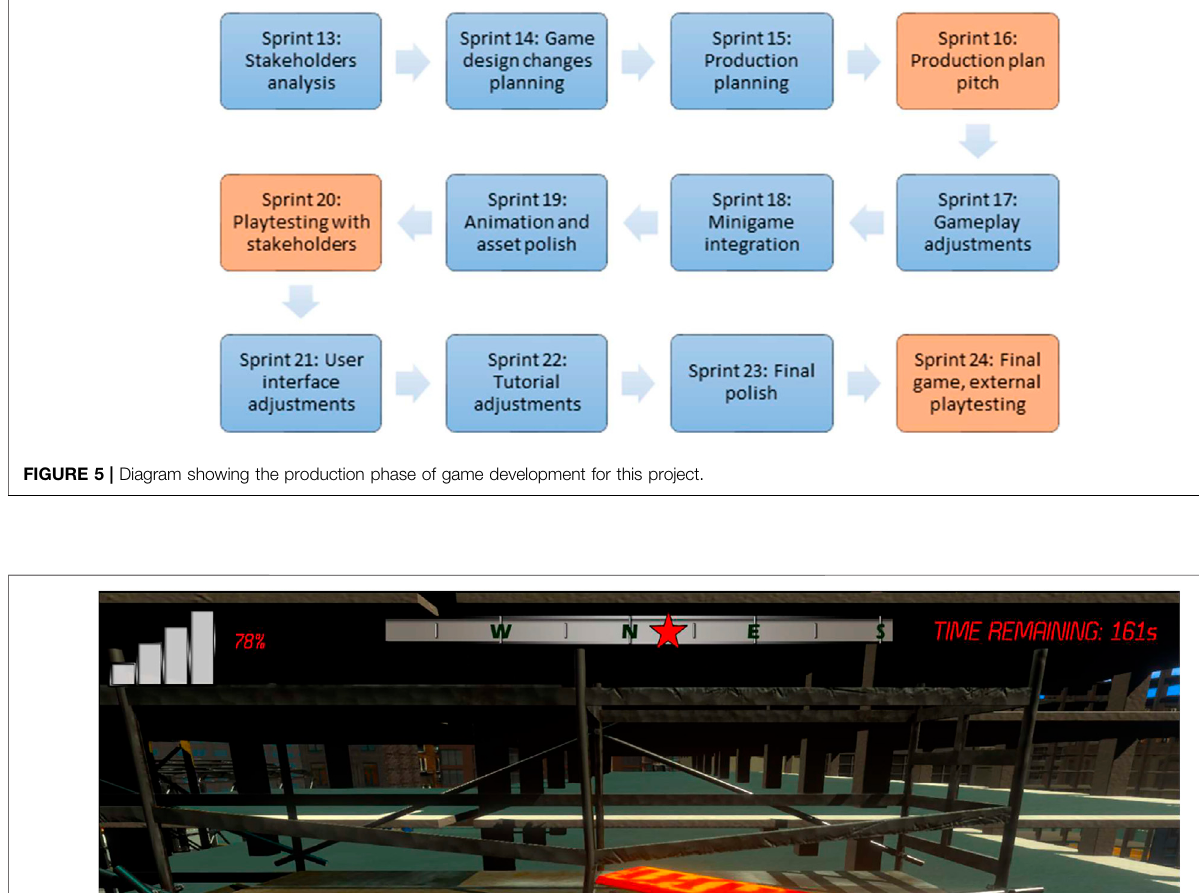
Frontiers in Built Environment |